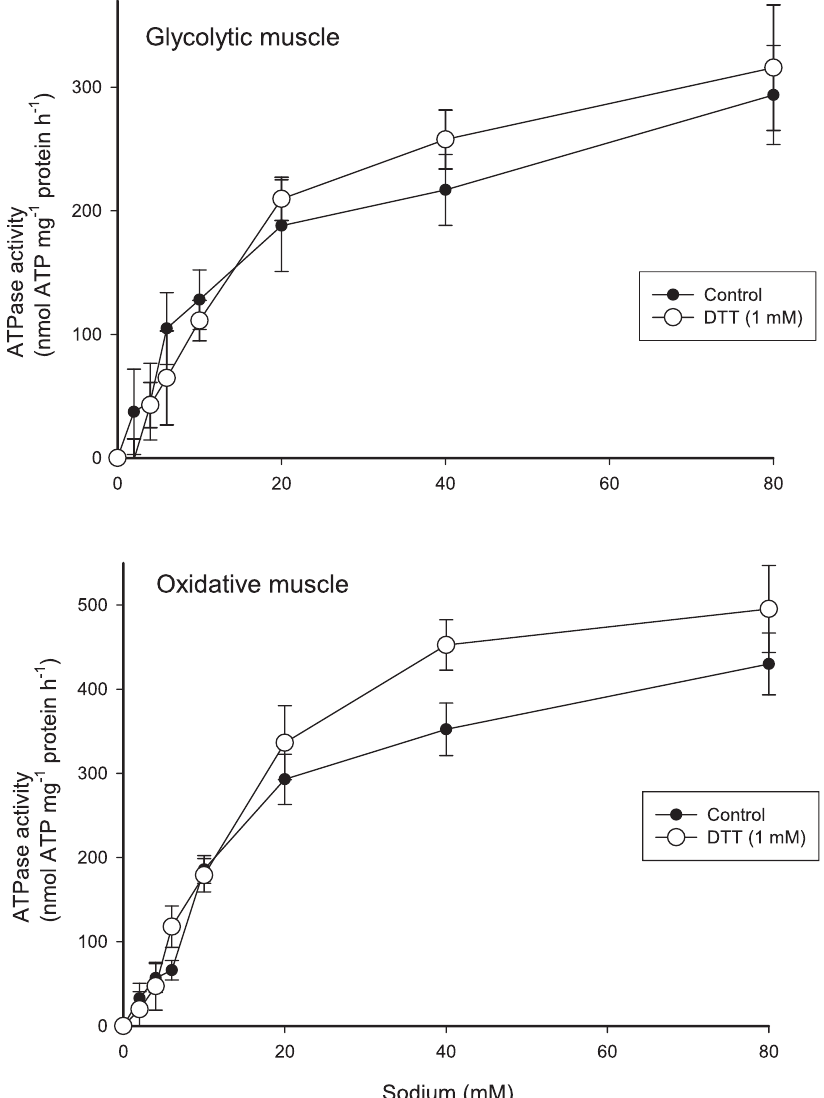
Figure 2. Effect of 1 mM DTT (dithiothreitol) on Na + -dependent Na,K-ATPase activity in purified muscle membranes from oxidative (lower panel) and glycolytic (upper panel) rat muscle. One sample from each rat was measured at each Na + concentration, the values therefore represent the mean from eight rats (Mean 6 SEM shown, n=8). Closed symbols: control. Open symbols: 1 mM DTT. For the oxidative muscle the mean V max with DTT was significantly higher than control (P ,